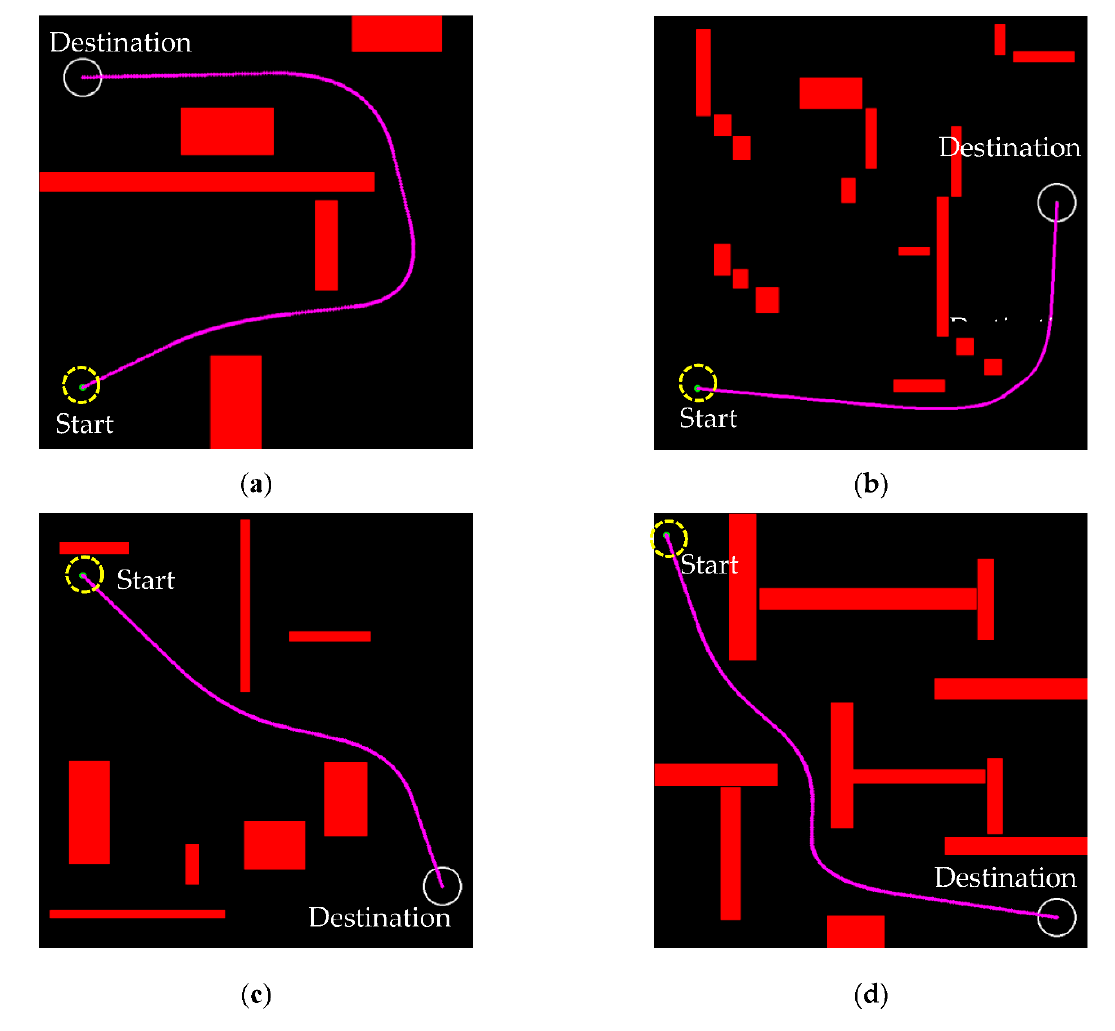
Figure 6. The results of path planning in four different obstacle avoidance environments ( a – d ) validate the effectiveness and efficiency of the improved RRT algorithm.